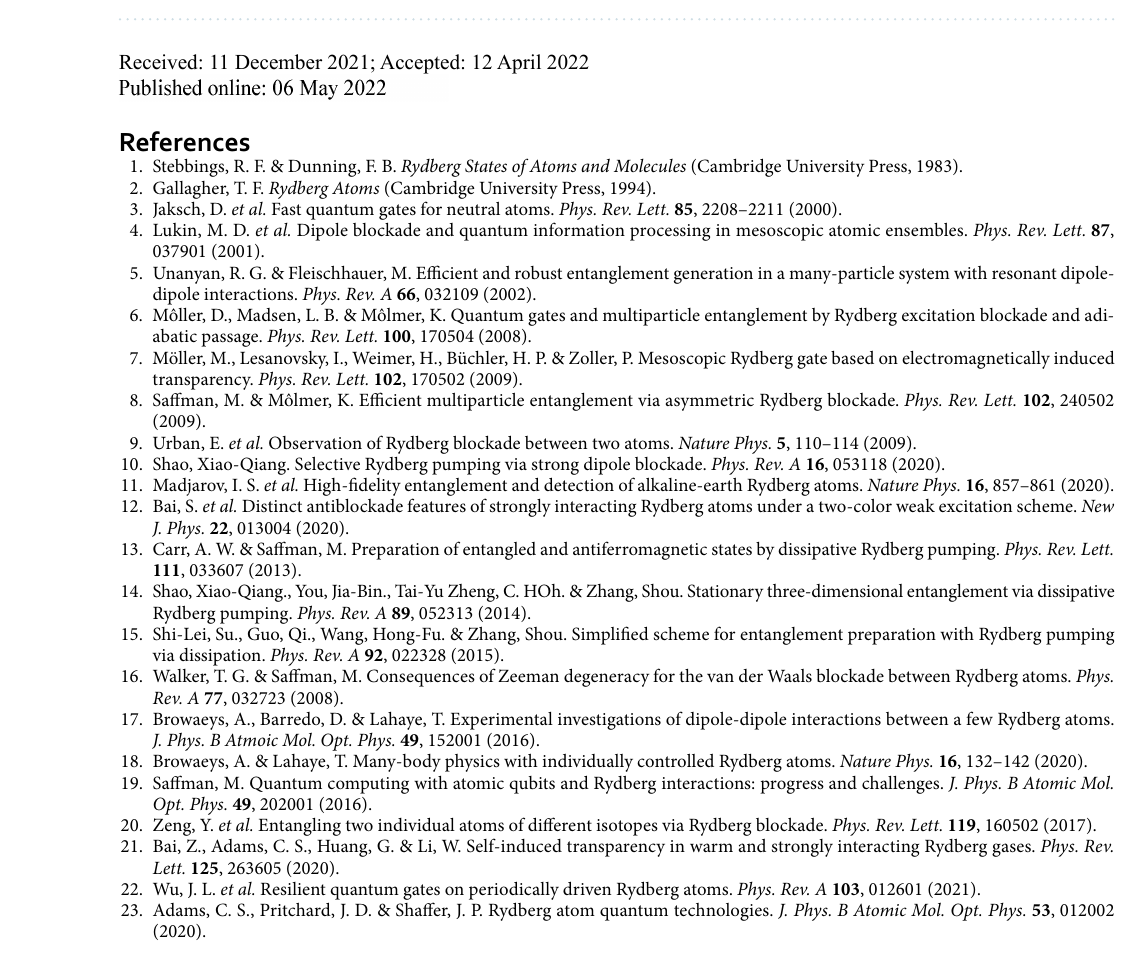
Figure 5. The variation of Heisenberg Uncertainty Principle (cid:31) r (cid:31) p with confinement radius r and atomic number Z for 7s state ( a ), 8s state ( b ), 9s state ( c ) and 10s state ( d ) of trapped Hydrogen-like